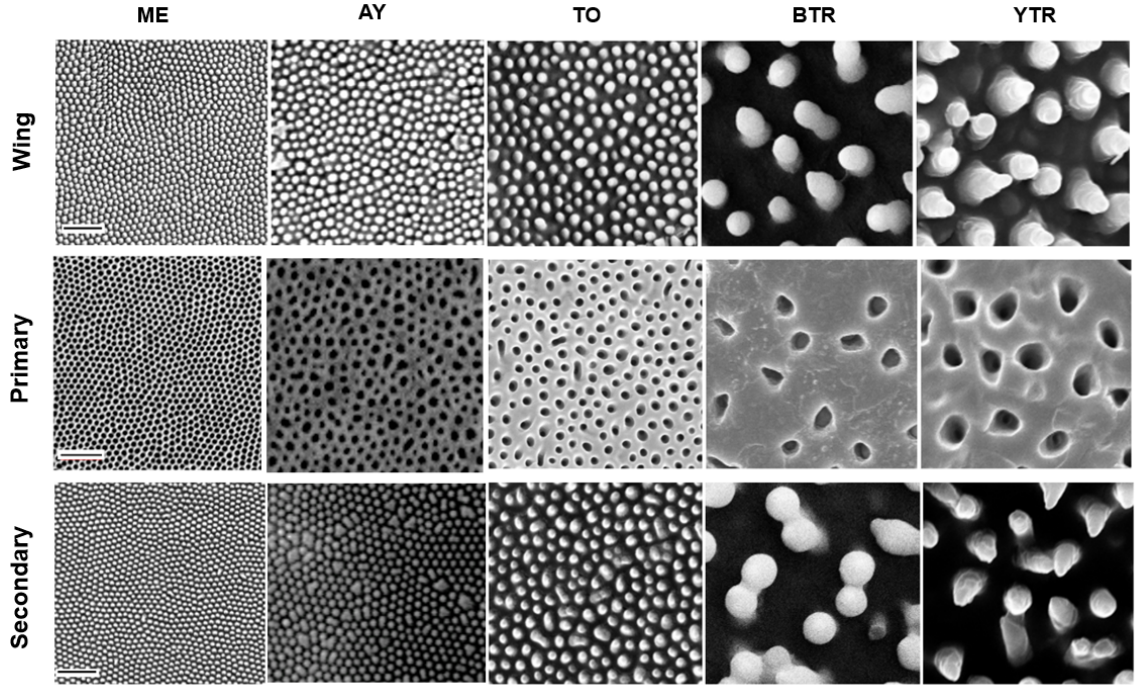
Figure 2. SEM images of the wings, primary molds, and secondary molds (scale bar is 1 µm and all images are the same size). Table 1. Feature sizes and water contact angles (WCAs) for the wings, primary molds, and sec- ondary molds. Species